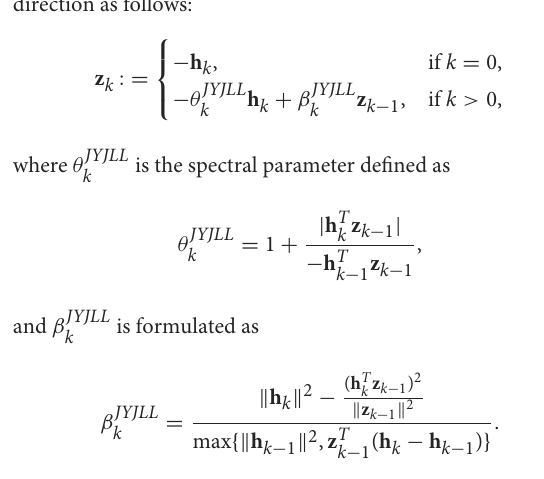
Algorithm 1. Spectral FMSD